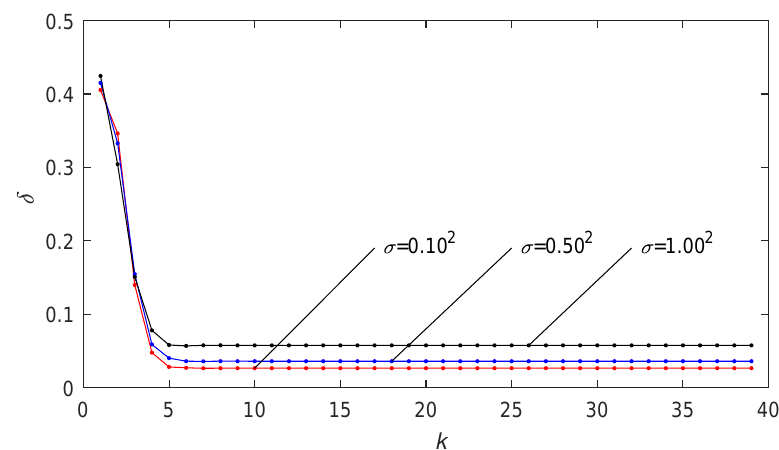
Figure 2. The VB parameter estimation error under different noise variance.